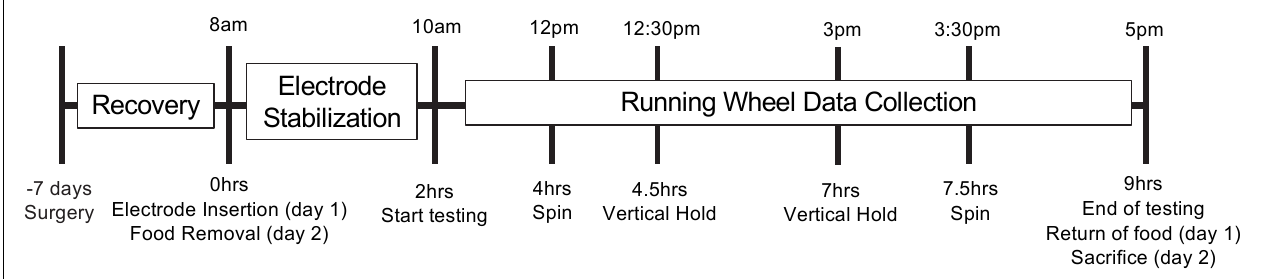
differences for extracellular glucose are indicated via a thin line. Differences from respective control groups are indicated by a gray shaded rectangle around the respective data